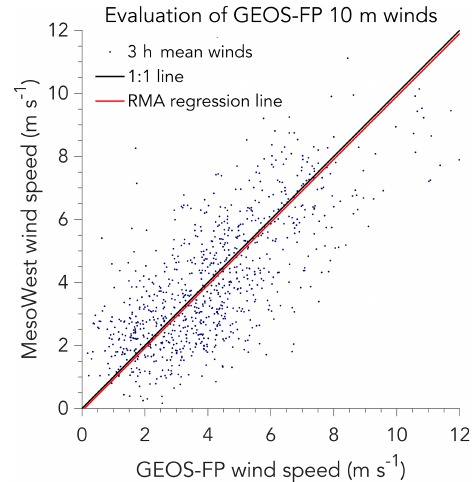
Figure 9. Evaluation of 10m wind speeds from the 3h GEOS- FP global database when used as estimate of local wind speed for source rate calculations in the IME and cross-sectional flux meth- ods. The figure compares 3h average 10m wind speeds from the MesoWest database measured at 10 US airports (ABQ, ATL, BOS, DFW, LAX, MCI, MSP, PDX, PHL, and PHX) to corresponding values from the GEOS-FP database. The GEOS-FP data have been corrected for a local roughness height z 0 , m = 0 . 025m (see text). The data are for daytime June 2017 (15:00–21:00UTC). The fit to a reduced major axis (RMA) regression line is also shown, which closely overlaps the 1 : 1